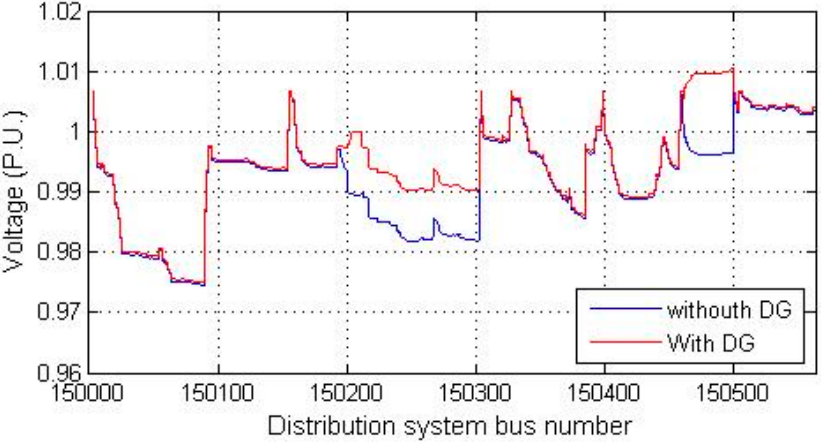
Energies 2017 , 10 , 1282 11 of 15